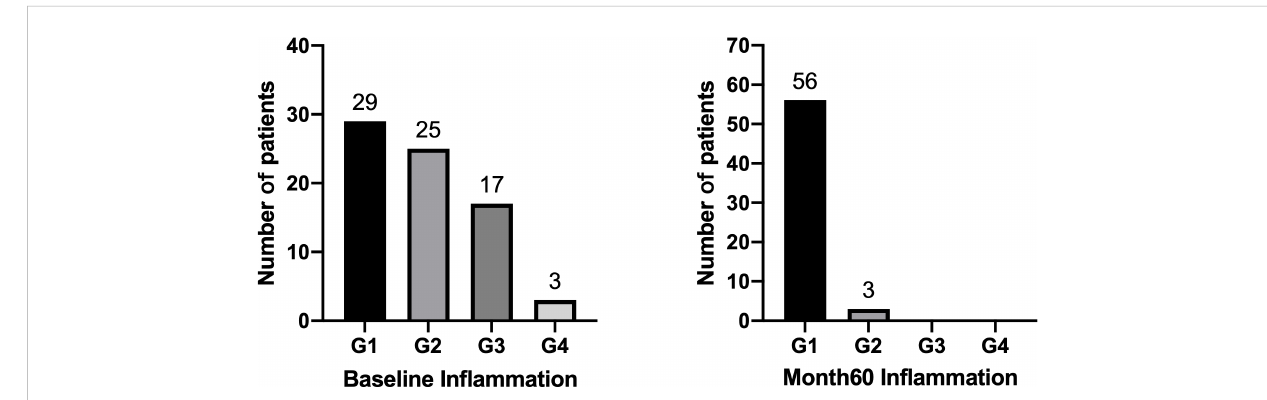
FIGURE 3 In fl ammation changes after 60 months of NAs therapy in HBeAg-positive CHB patients.